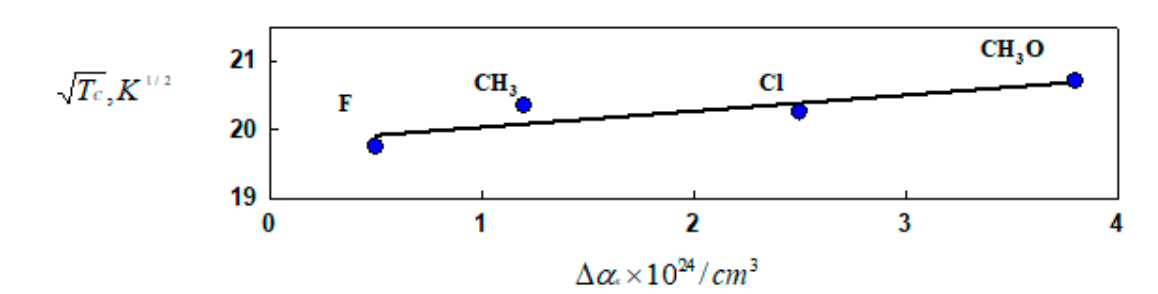
√ T C ) dependency on the polarizability anisotropy ( ∆ α X ) of the terminal attached substituent Figure 5. Mesophase stability ( Figure 5. Mesophase stability ( T ) dependency on the polarizability anisotropy ( Δα X ) of the terminal attached C (X) of the present series of I6 a–e . substituent (X) of the present series of I6 a–e .